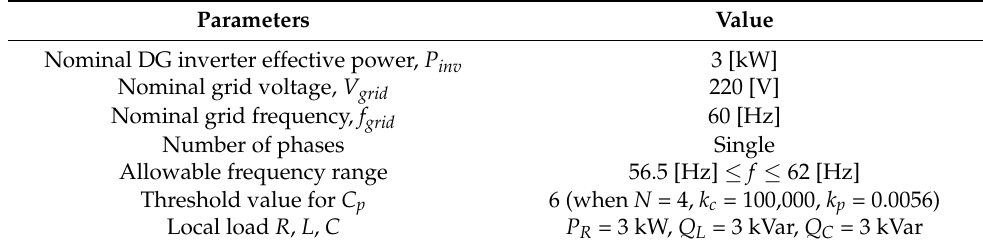
Figure 2. Simulation circuit for islanding detection test. Table 4. Electrical specification of the simulation